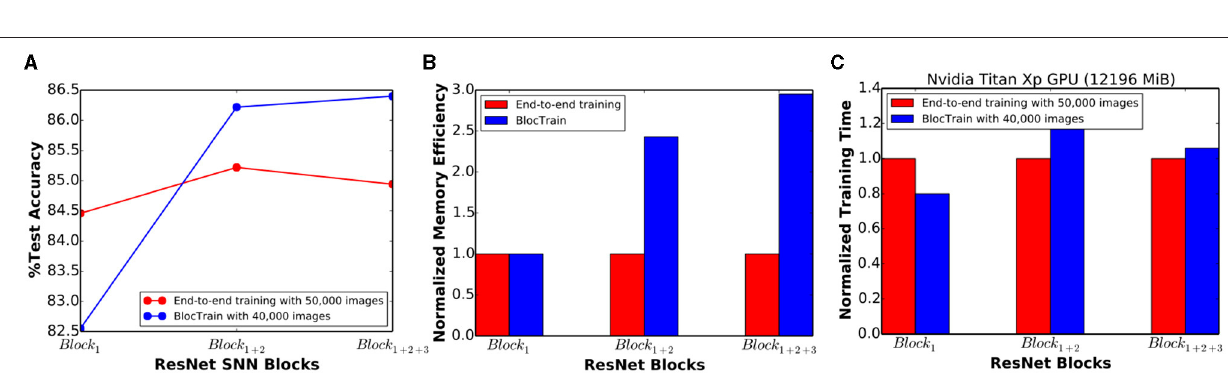
FIGURE 5 | (A) Test accuracy, (B) normalized training memory efficiency, and (C) normalized training time offered by BlocTrain over end-to-end training for ResNet-5 ( Block 1 ), ResNet-7 ( Block 1 + 2 ), and ResNet-9 ( Block 1 + 2 + 3 ) spiking neural networks